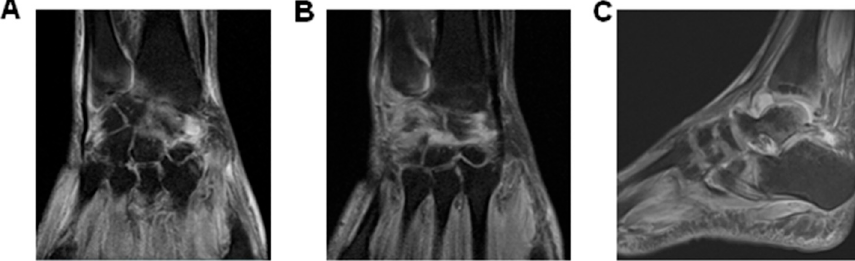
Figure 2. Development of severe tenosynovitis during arboviral coinfection. MRI of wrists and right ankle was performed 278 days post symptom onset to assess joint inflammatory evolvement showed in ( A ) (right wrist) and ( B ) (left wrist), synovitis and tenosynovitis bilaterally. Coronal images demonstrated the presence of edema and excessive fluid in carpus and radioulnar joints, and also in flexor and extensor compartments. ( C ) sagittal MRI Diffusion-Prepared (DP) weighted sequence with fat suppression image of the right ankle showing synovial overgrowth within the tibiotalar and intertarsal joints. Signs of plantar fasciitis and hyperintense abnormality were also observed, corresponding to a pattern of edema.